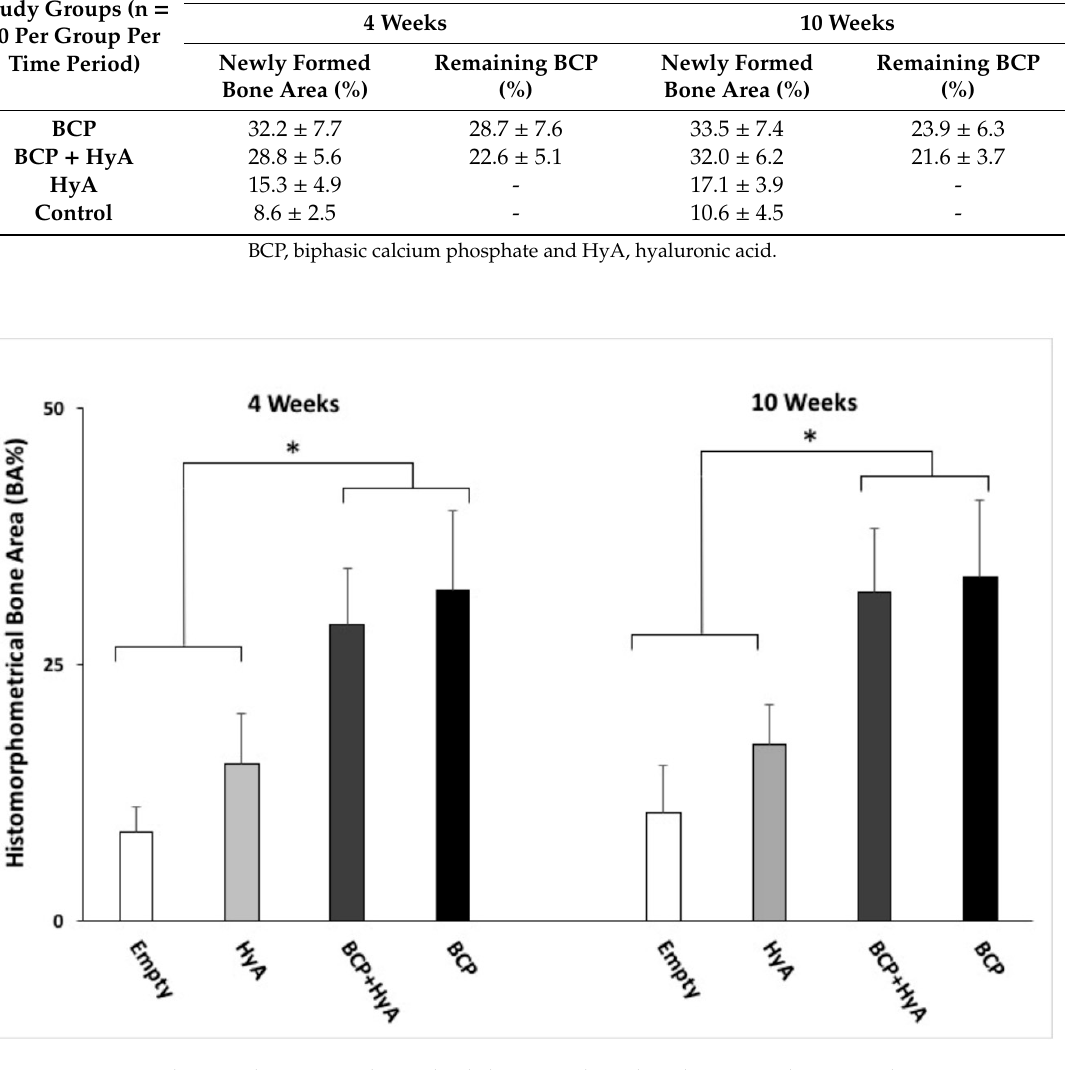
Figure 5. Bar-chart with mean and standard deviation based on histomorphometrical assessment showing bone area (BA%) for all study groups at 4 weeks and 10 weeks. (* indicates p<0.05)